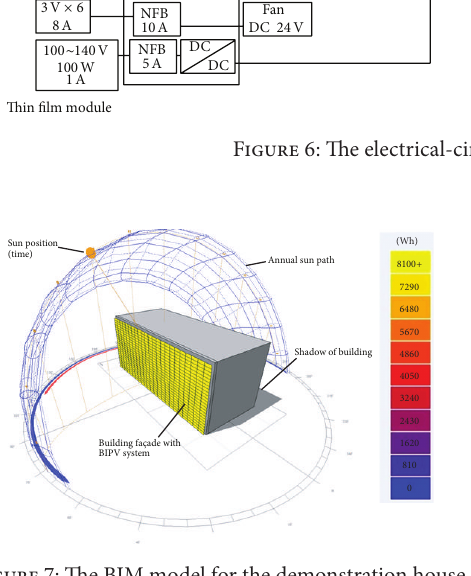
Figure 7: The BIM model for the demonstration house.